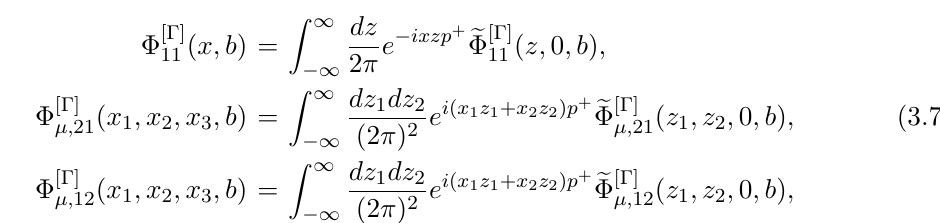
Figure 3 . Illustration for the elements of the evolution kernel. Left panel: the function Θ x defined in eq. (3.14). The same shading of the segment corresponds to the same coefficient. The LO value for the coefficient is written inside each sector. Right panel: example of the integration paths for the evolution kernel P in the barycentric coordinates. The black and white dot represent x 2 x 1 the coordinates of the special points of the integral kernels ( v = 0 ). The black one for the ‘natural’ ordered coordinates. The white one for the exchanged quark and gluon momenta, which take place in the last lines of eqs. (3.15),